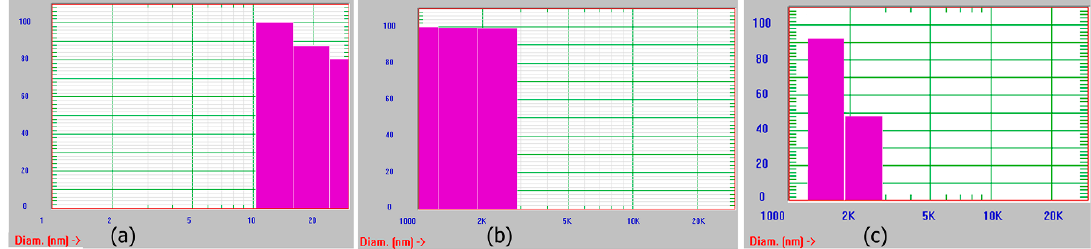
Figure 3. Dynamic light scattering analyses of assemblies formed at ( a ) pH 4; ( b ) pH 7 and ( c ) pH